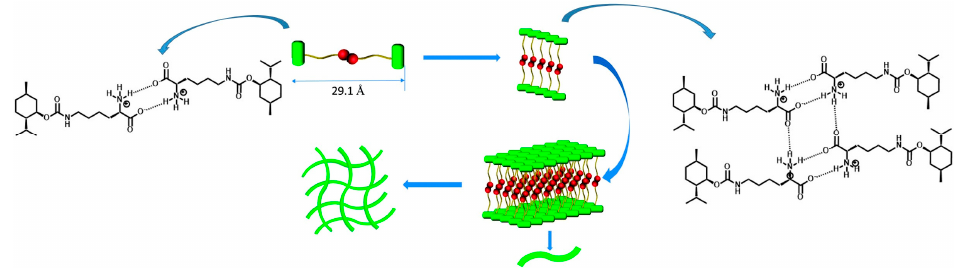
Figure 6. The simulative diagram of the self-assembly process of the hydrogelator based on ( − )-menthol. Image adapted with permission from reference [47]. Copyright 2014 Royal Society of Chemistry.